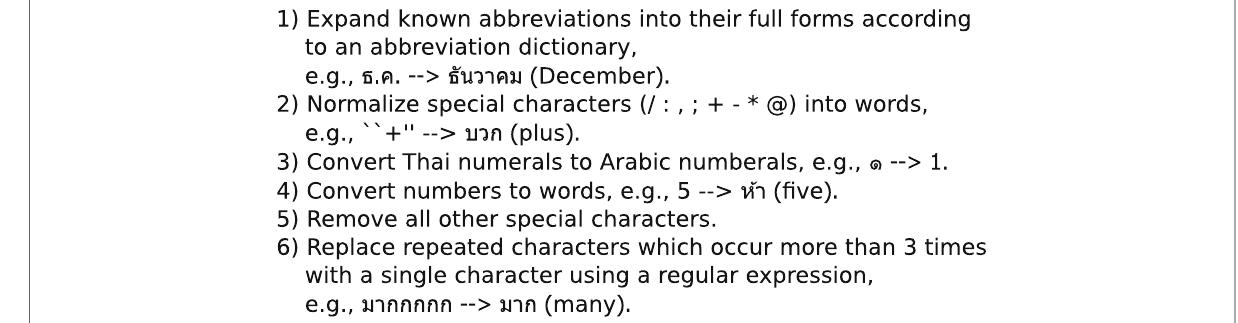
Fig. 1 Normalization rules for Twitter